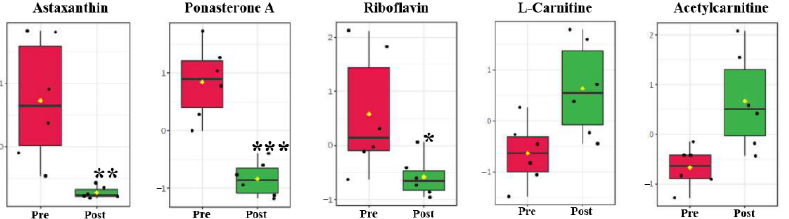
Figure 5. Change in astaxanthin, ponasterone A, riboflavin, L -carnitine, and acetylcarnitine between pre- and post-pubertal molting groups. Values are mean and standard deviation. Pre, pre-pubertal molt group. Post, post-pubertal molt group. Asterisks *, **, and *** denote significant difference at the p < 0.05, p < 0.01, and p < 0.001 levels, respectively.